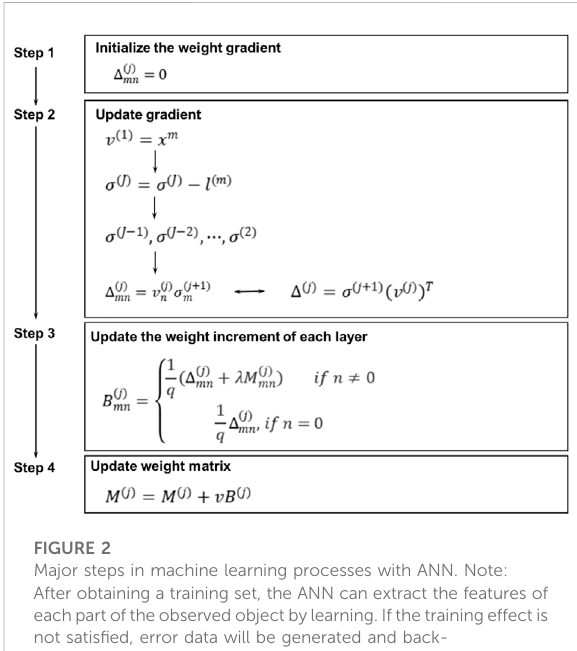
FIGURE 2 Major steps in machine learning processes with ANN. Note: After obtaining a training set, the ANN can extract the features of eachpartoftheobservedobjectbylearning.Ifthetrainingeffectis not satis fi ed, error data will be generated and back- propagated and relevant parameters will be adjusted according